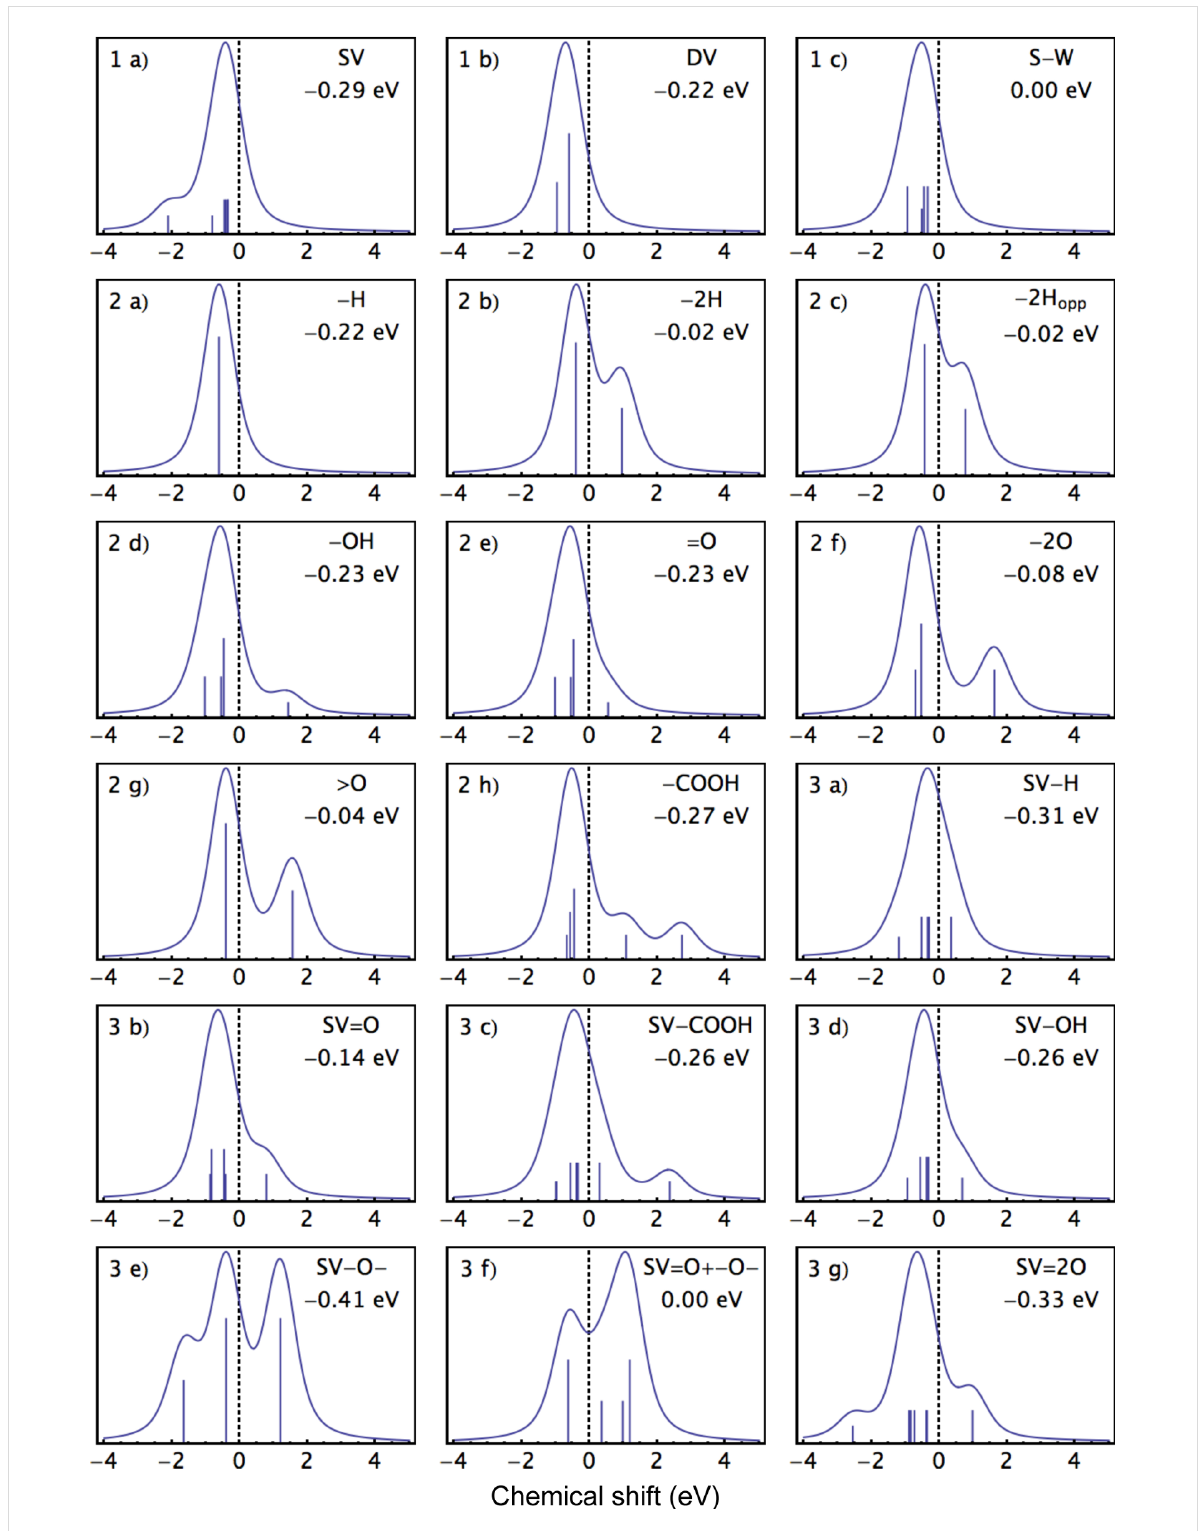
Figure 4: The calculated line shapes, in which peaks with shifts smaller than 0.3 eV from the system bulk value have been suppressed. The identifier in the top left corner of each panel refers to the corresponding structures in Figures 1–3, while the energy inset under the system identifier in the top right corner denotes the shift of the system bulk value compared to that of pristine graphene. The vertical lines represent the shifts of the calculated binding energies with respect to the system bulk value, weighted by the number of atoms for each calculated energy and scaled for